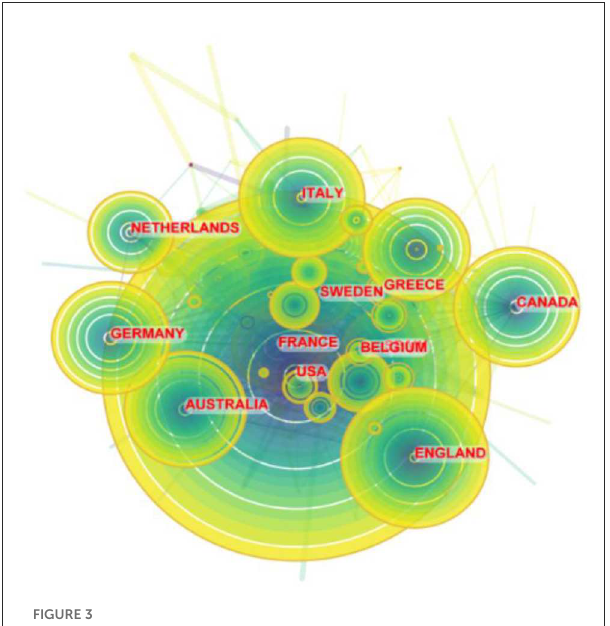
FIGURE3 Map of countries/regions on LChD from 2002 to 2021.